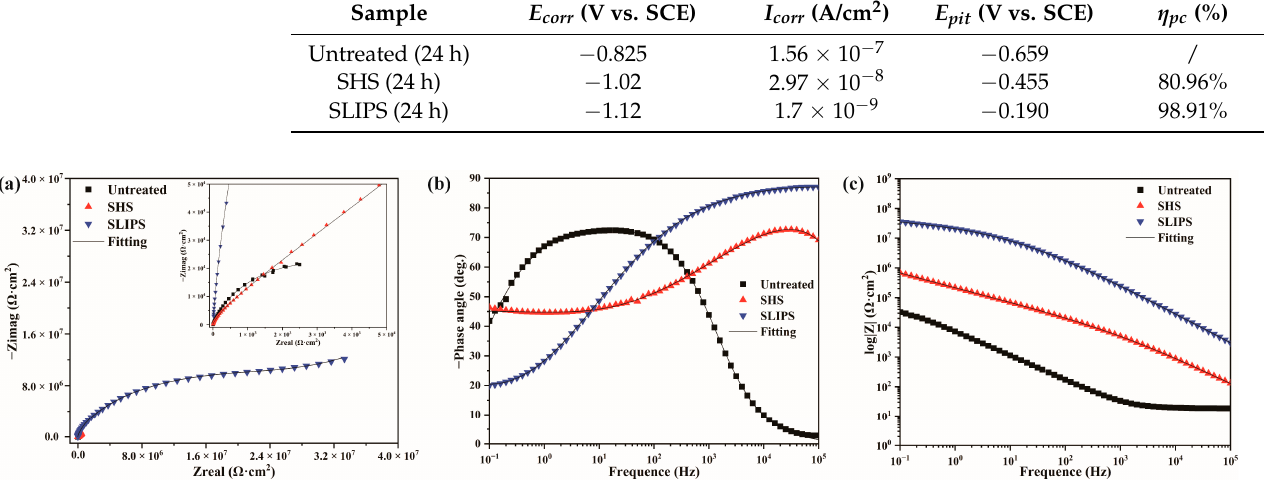
Table 4. Electrochemical parameters obtained from EIS simulation with equivalent circuit after im ‐ mersion in simulated seawater for 24 h.